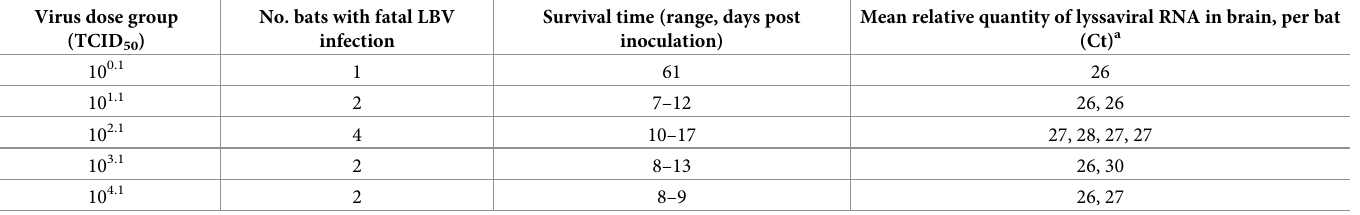
Table 2. Comparison of survival time and relative quantity of Lagos bat virus RNA in the brains of straw-colored fruit bats inoculated with different doses of Lagos bat virus. (Four bats in each virus dose group.) Virus dose group No. bats with fatal LBV Survival time (range, days post (TCID 50 ) infection